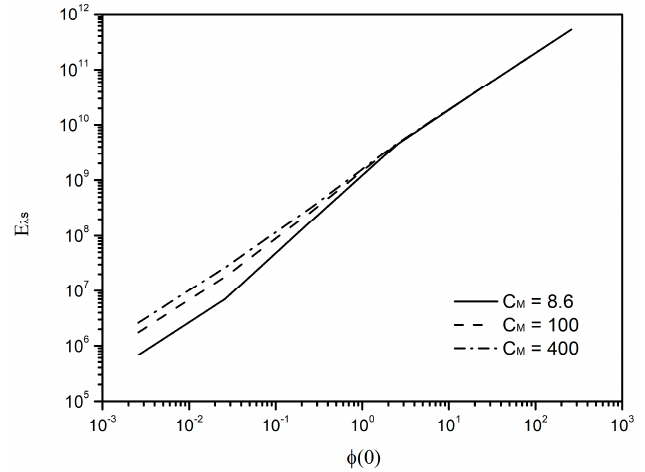
Figure 5. Electric field intensity inside the compact layer dependance on ϕ ( 0 ) for various C M .